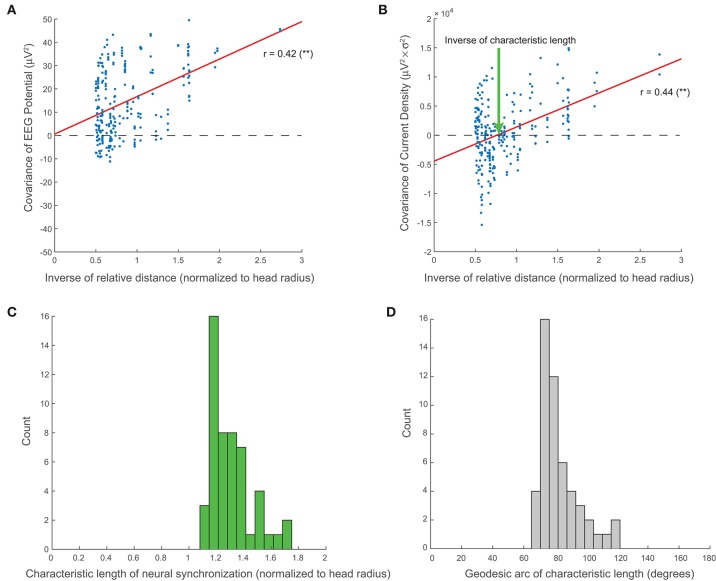
Large-scale neural synchronization. (A) As predicted by our theory (see Methods), the covariance of the EEG potential is proportional to the inverse of the relative distance. This proportionality is direct, i.e., the abscissa intercept of regression is essentially zero. (B) Empirically, the covariance of the current sources also shows a similar correlation with inverse distance, but with an additional horizontal offset which represents the inverse of the characteristic length of large-scale neural synchronization (normalized to the head radius). (C) Across all subjects, the characteristic length, D, clusters tightly around a mean of 1.31 (normalized to the head radius). (D) The angular length, or geodesic arc of the characteristic length, γ, clusters around a mean of 82.4°.